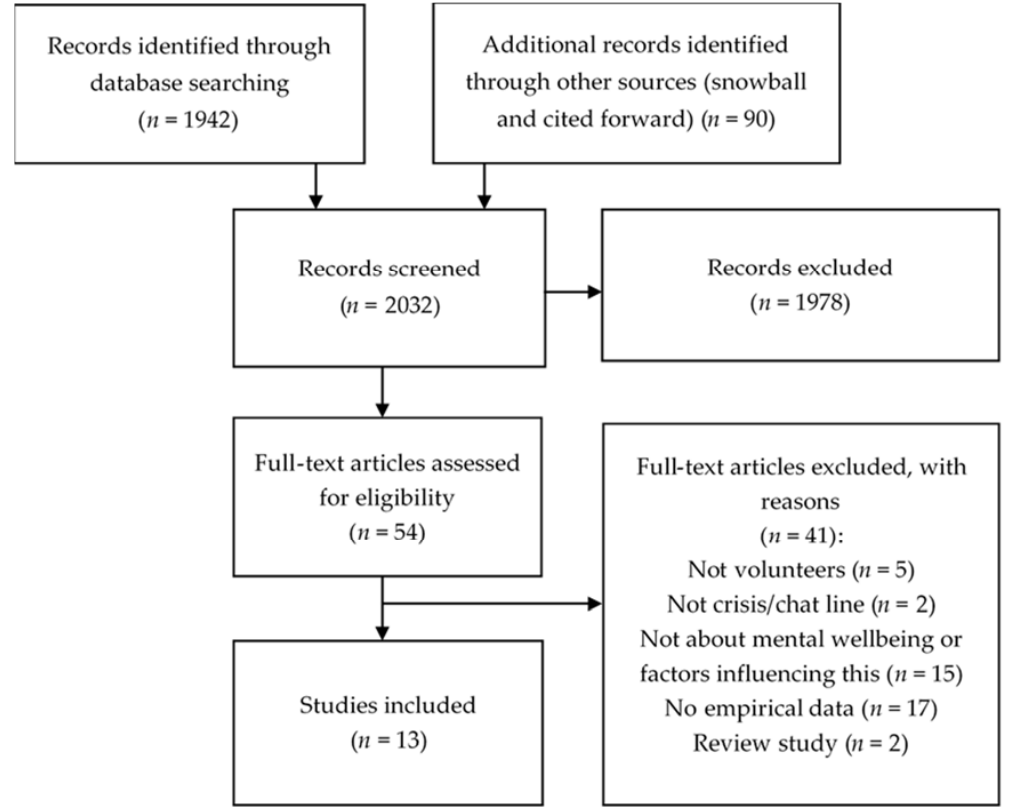
Figure 1. Flow chart of included studies.